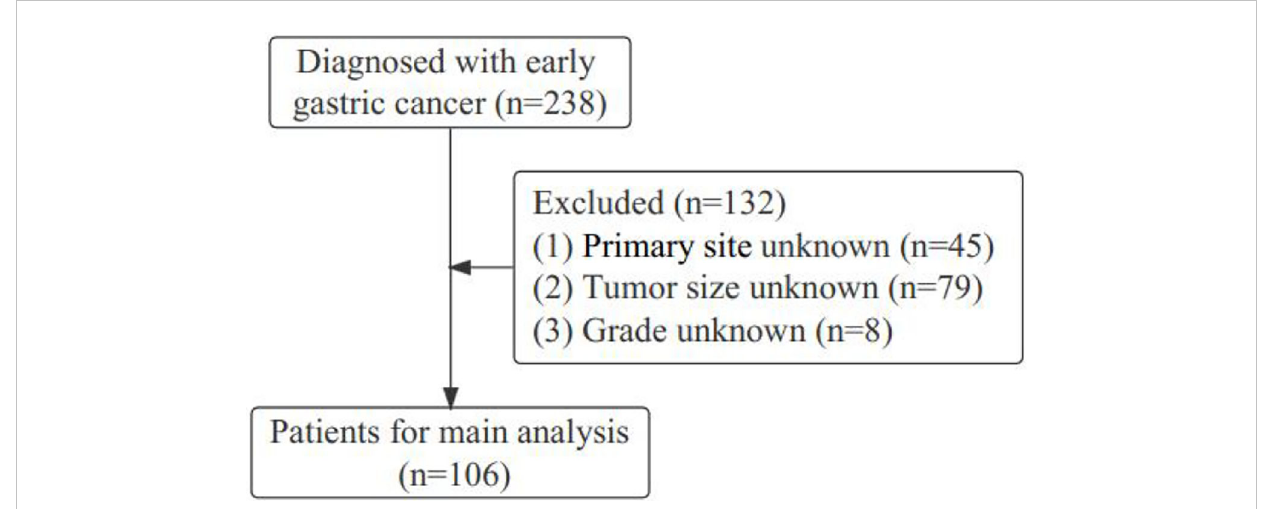
FIGURE 2 The diagram of the patient screening process in the Second Hospital of Lanzhou University.